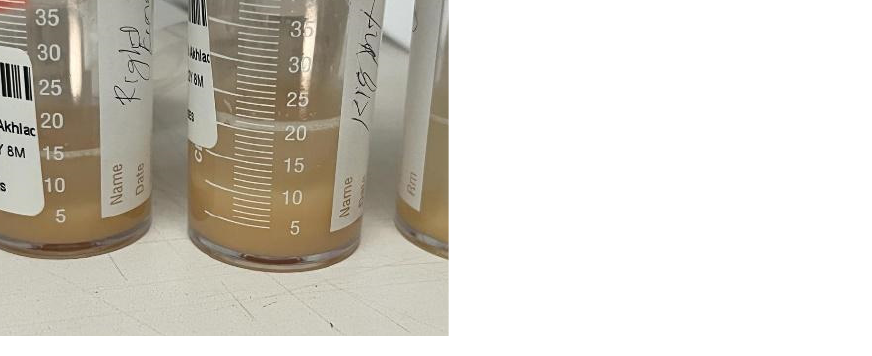
Figure 3. Lung lavage, turbid secretion a little frothy, and sedimentation of material deposited in the lower part of the container suggestive of PAP.